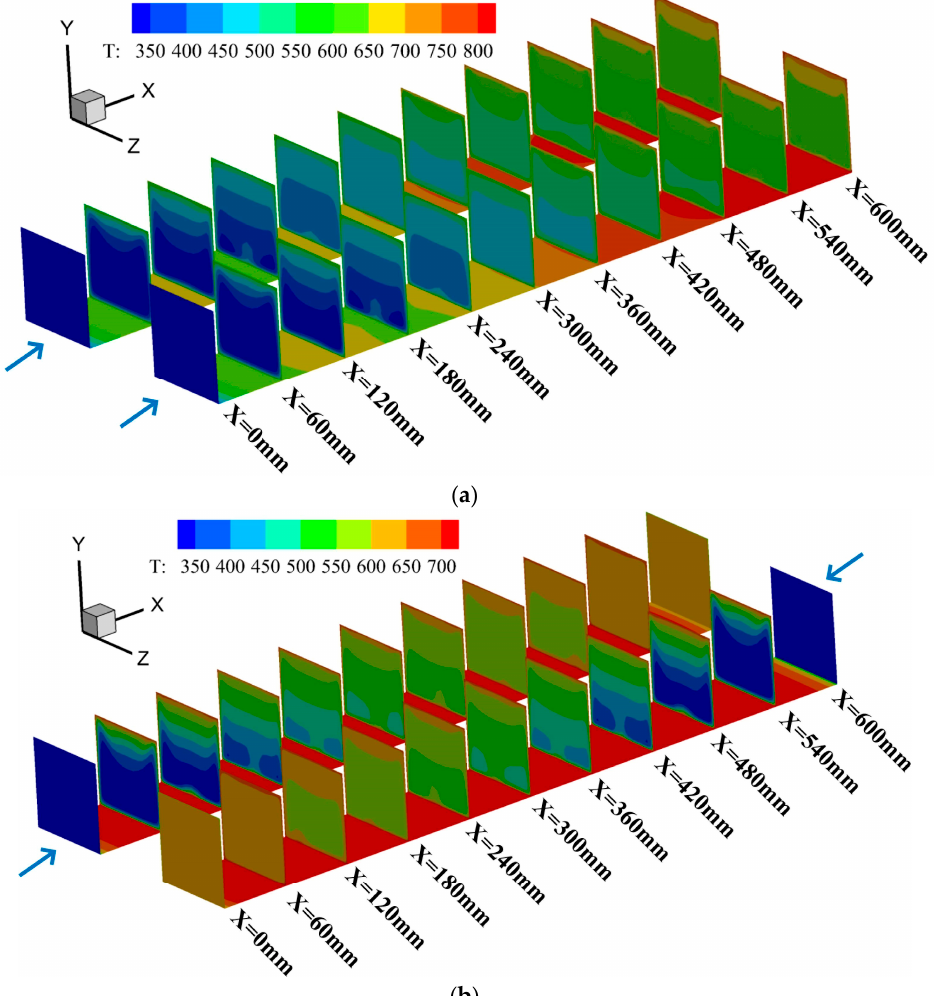
Figure 8. The fluid temperature distribution along the flow direction: ( a ) Case A; ( b ) Case B. It is obvious that the fluid temperature distribution also exhibits a good symmetry along the flow direction. By comparing the fluid temperatures along the flow direction, the temperature near the bottom wall is relatively low, while the temperature near the top wall is relatively high. Although the same phenomenon is found in case B, the cross-sec- tional temperature is relatively uniform near the outlet. These results may occur because